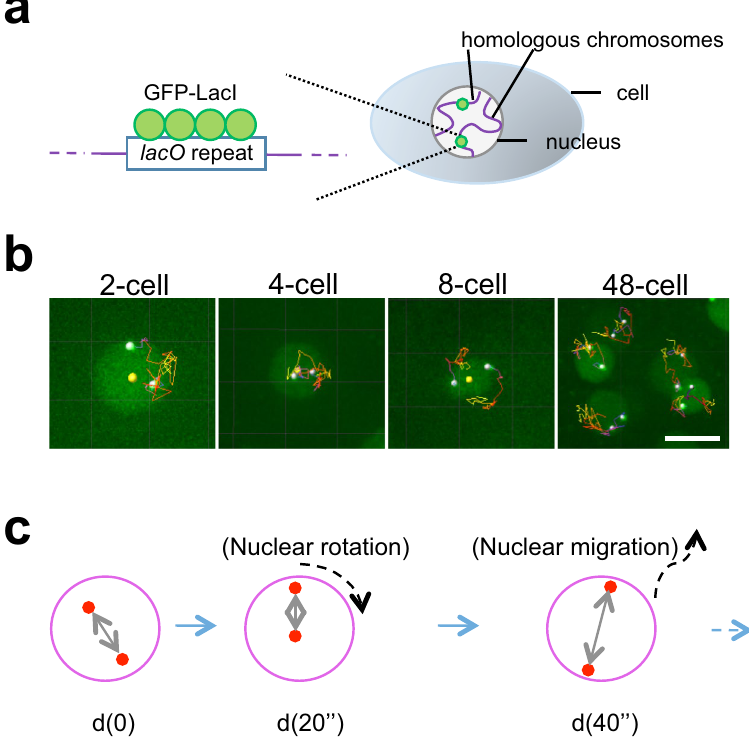
Figure 1. 4D tracking analysis of lacO spots during C . elegans embryogenesis. ( a ) Schematic of the visualization of a pair of homologous loci in the C . elegans embryos. A lacO repeat was integrated into the C . elegans genome and detected by expression of the LacI protein fused to GFP. ( b ) Representative examples of lacO tracking at indicated stages. Two white dots in each panel show the lacO spots, and the yellow dot reveals the centre of the nucleus (not shown for the 48-cell stage). Lines show the trajectories of the lacO spots. Bar, 5 μ m. ( c ) The distance between the two spots ( d ) reflects the mobility of the spots, excluding the effect of nuclear rotation and migration. d (0), d (20 ″ ), and d (40 ″ ) represent the distances between the two loci at time 0, 20, and 40 s,